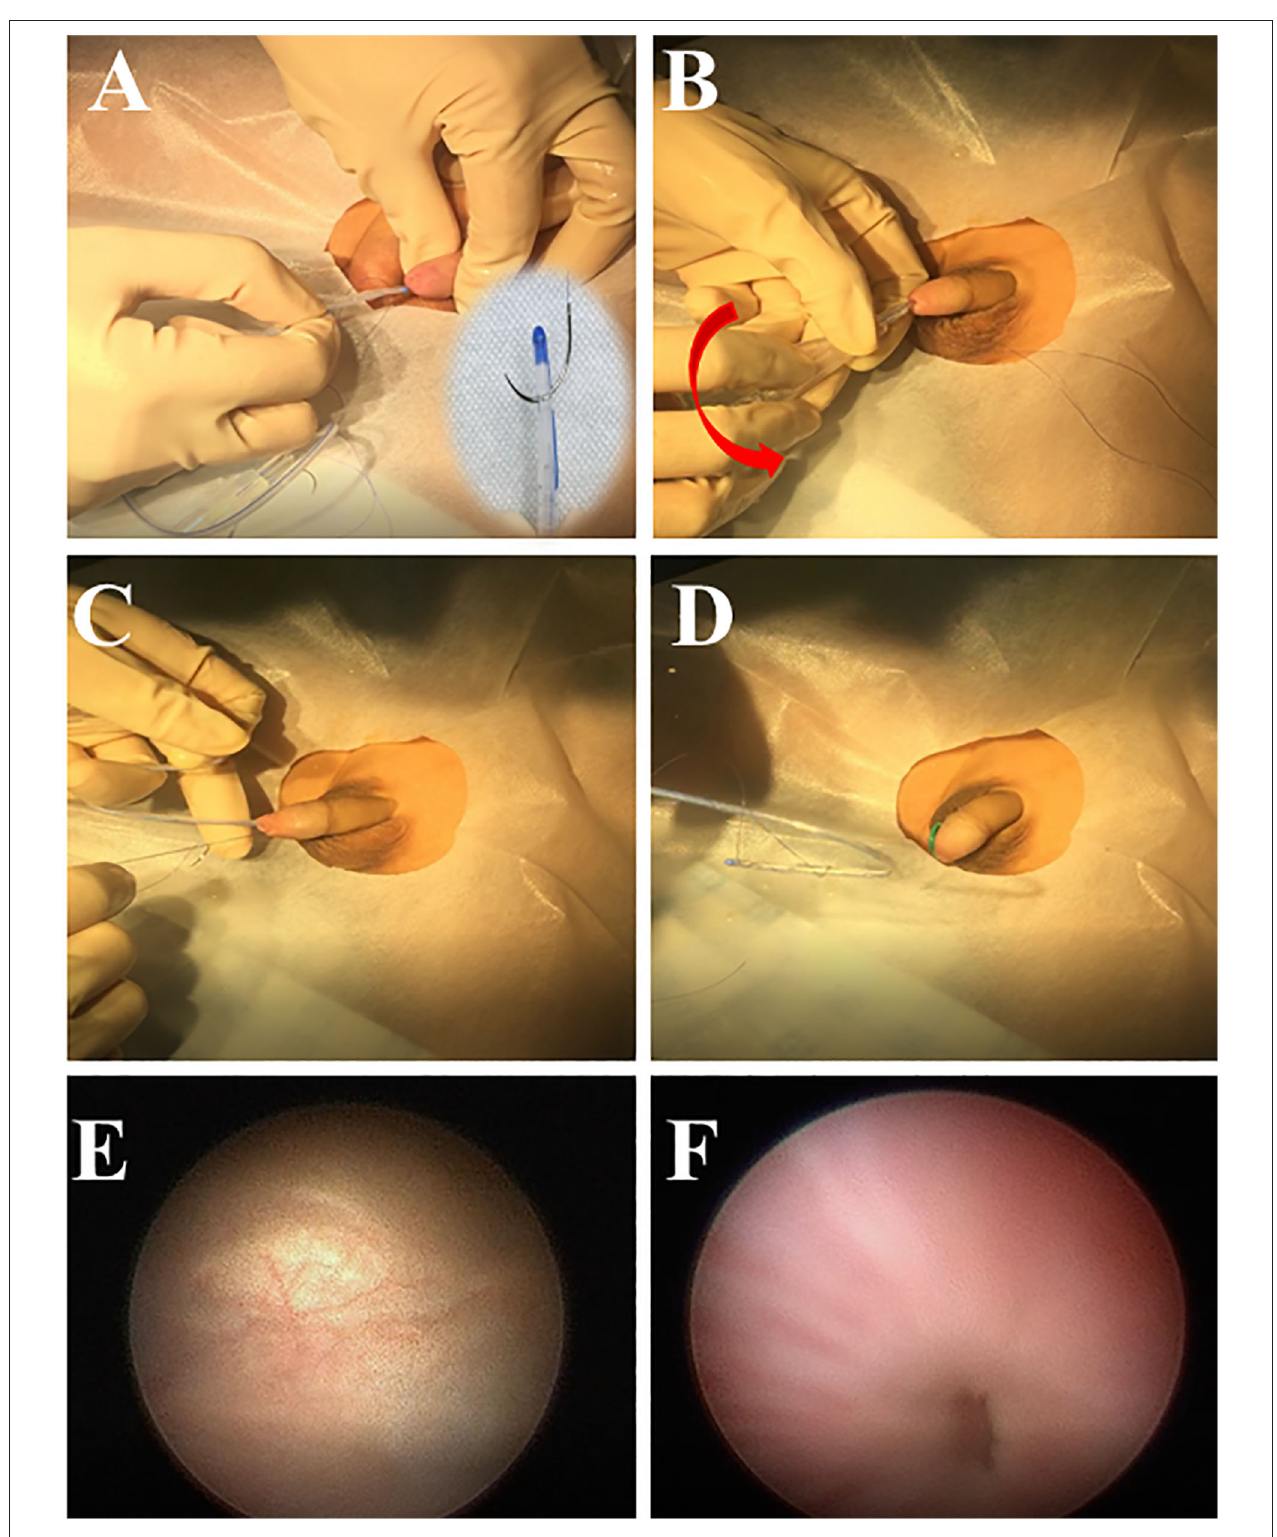
FIGURE 1 | The surgical procedure of modified double-J ureteral tube removal. A 5–0 suture is threaded through the front opening of the Foley catheter, and the suture is folded back and placed into the bladder with the catheter (A) ; the catheter is rotated (B) ; the catheter is pulled out, and suture string is tensioned (C) ; double-J tube is pulled out with the catheter and suture (D) ; Re-examination of the bladder (E) ; and urethral (F) injury after the non-cystoscopic removal of double-J tubes.